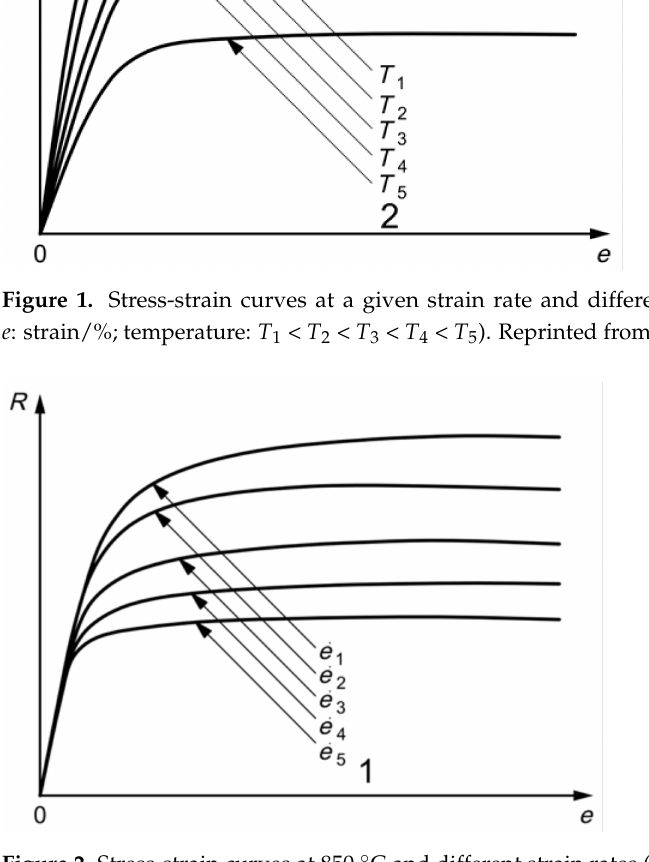
Figure 2. Stress-strain curves at 850 ◦ C and different strain rates ( R : stress/MPa; e : strain/%; strain . . . . . e 1 > e 2 > e 3 > e 4 > e 5 ). Reprinted from ref. rate: